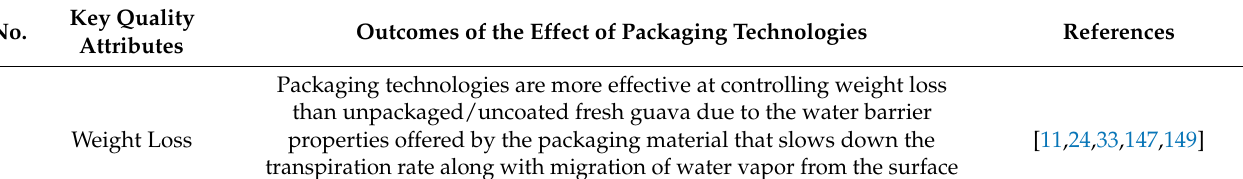
Table 4. Main outcomes of the effect of packaging technologies on guava